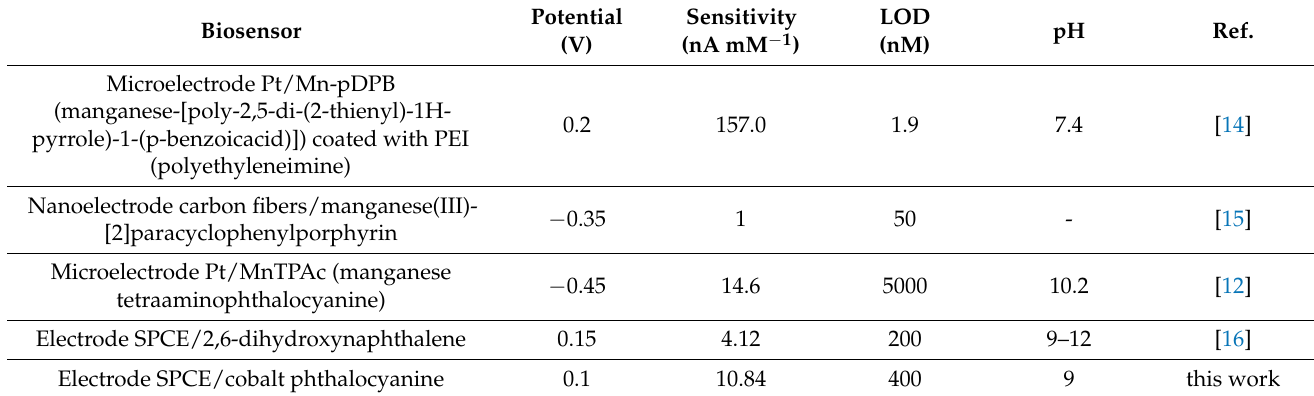
Table 1. Literature study of the developed sensors used to detect PON via electroreduction. Potential Biosensor (V)